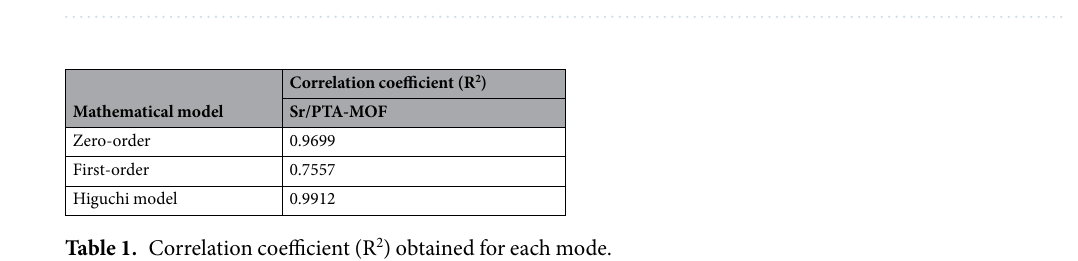
Figure 5. ( a ) Ketoprofen release from Sr/PTA-MOF in PBS; ( b ) Fitting of the ketoprofen delivery data to a Higuchi model.